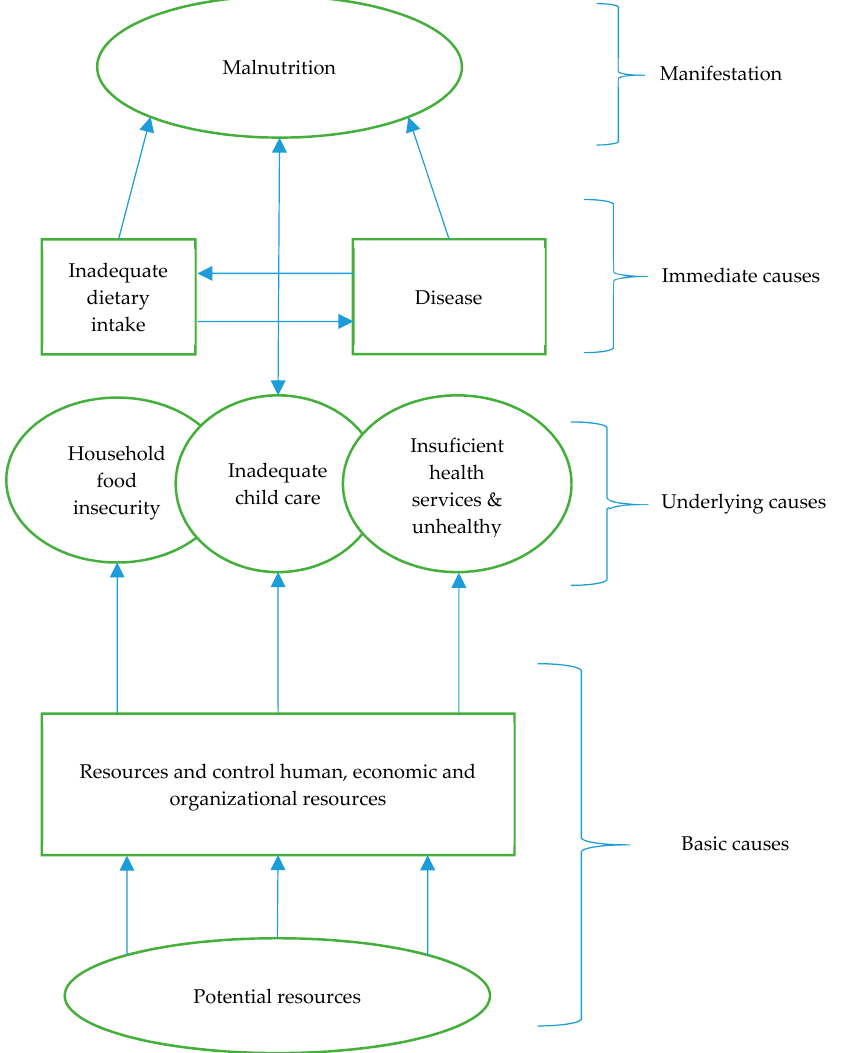
Figure 1. United Nations International Children’s Emergency Fund’s (UNICEF) conceptual framework of the causes of child malnutrition. Source: Adapted from Ravindranath et al. [24]. Neighbouring countries such as Botswana and Namibia identified low birth weight as one of the contributing factors to child malnutrition [26,27]. Therefore, low birth weight was also hypothesized